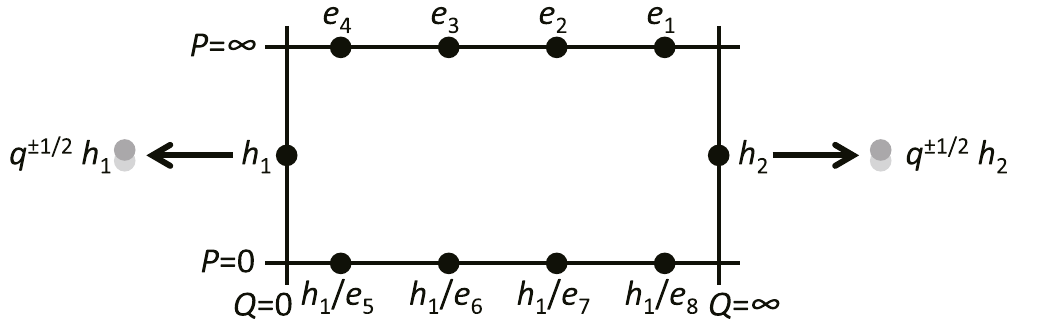
Figure 6 . The Newton polygon of the E 7 del Pezzo curve.